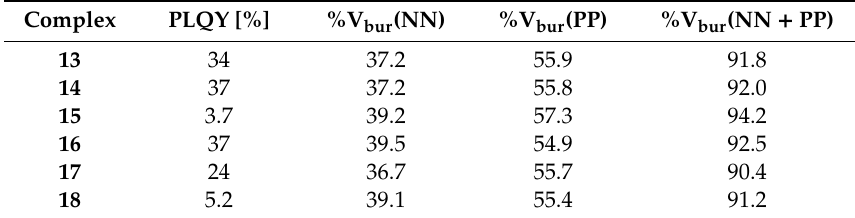
Table 3. Reported PLQY values for powder samples for copper(I) complexes and %V bur for (NN), (PP), and (NN)(PP) units. Data are from reference [18].